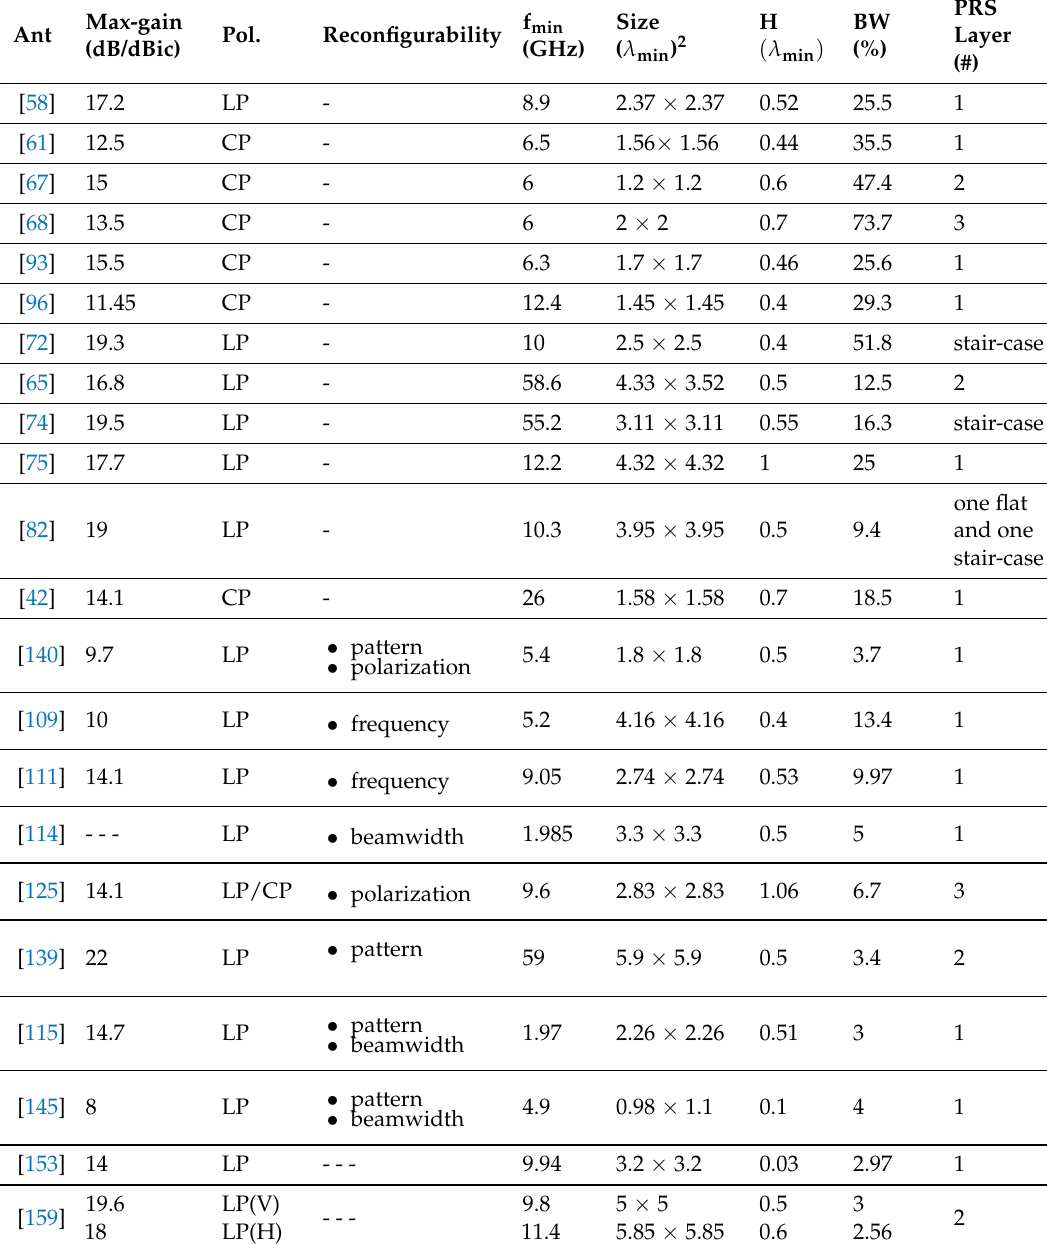
Table 1. Comparison between different